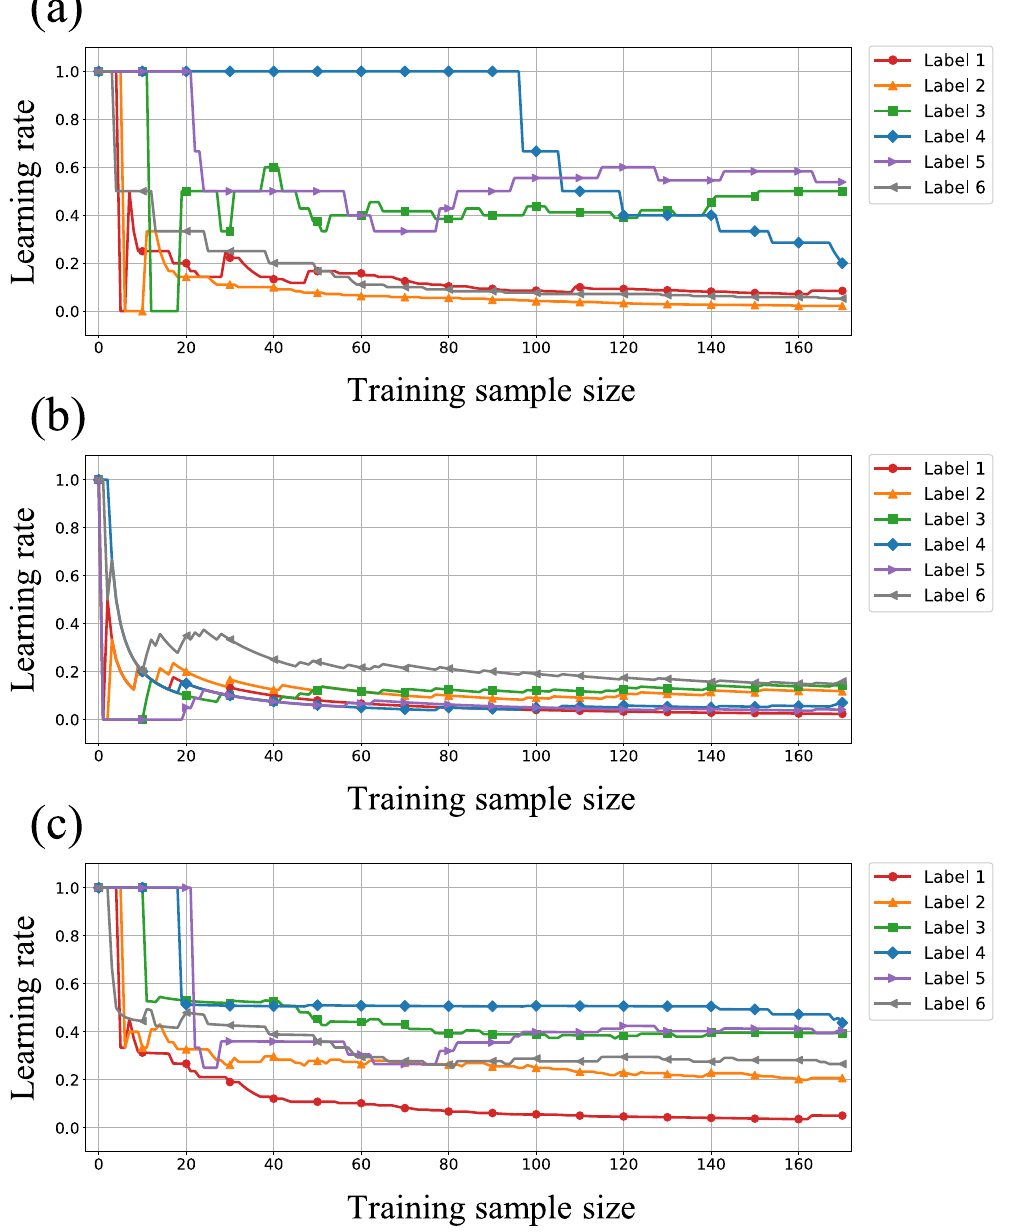
Figure 5. Transition diagram of the learning rate in SILVQ. The figure shows the learning rate of each model at each learning stage of the Glass dataset. Each model has six learning rates corresponding to each label. ( a ) Results for SILVQ–CP. ( b ) Results for SILVQ–RS. ( c ) Results for